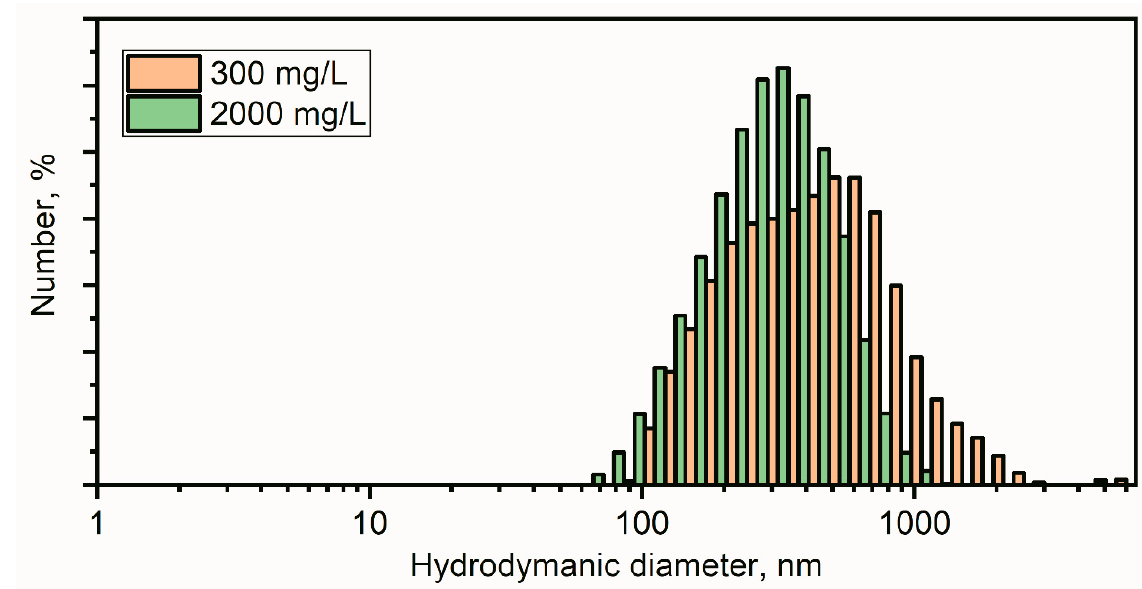
Figure 3. DLS of 300 mg/L and 2000 mg/L colloidal solution of ZnO nanoparticles.